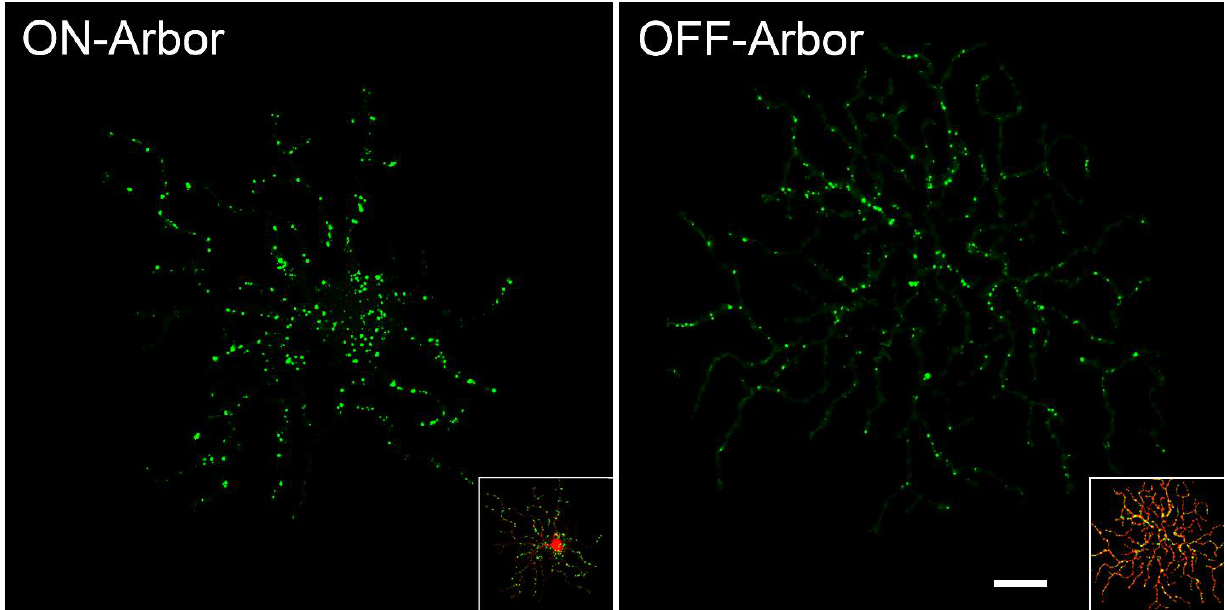
Figure 5. Mitochondrial density in the arbors of a single ON-OFF RGC. Masked out ON and OFF arbors of a single cell showing the distribution of CFP-labeled mitochondria in each (Imaris rendering). The inset shows each arbor (and cell soma with the ON arbor) with the tdTomato cell fill label included. The OFF arbor is larger and more complex, but appears to have a lower density of mitochondria compared to the ON arbor. Scale Bar = 50 µm.